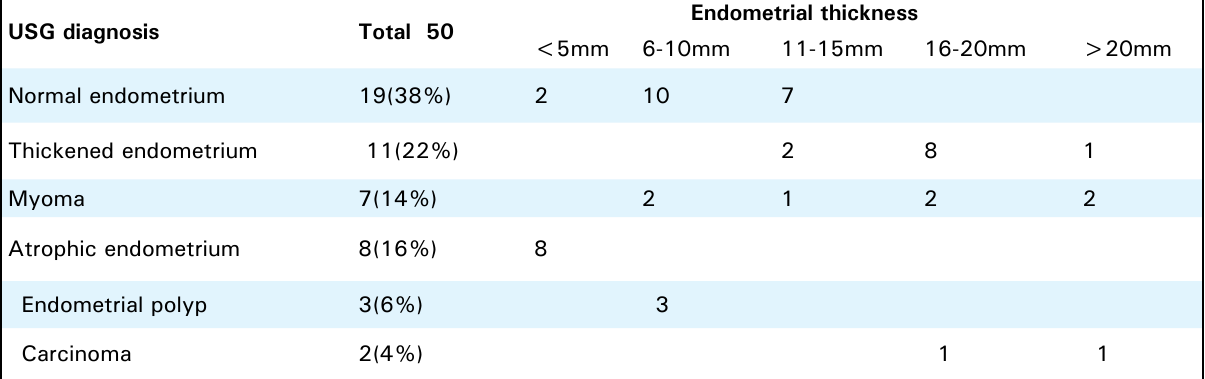
table 2. UsG diagnosis and endometrial